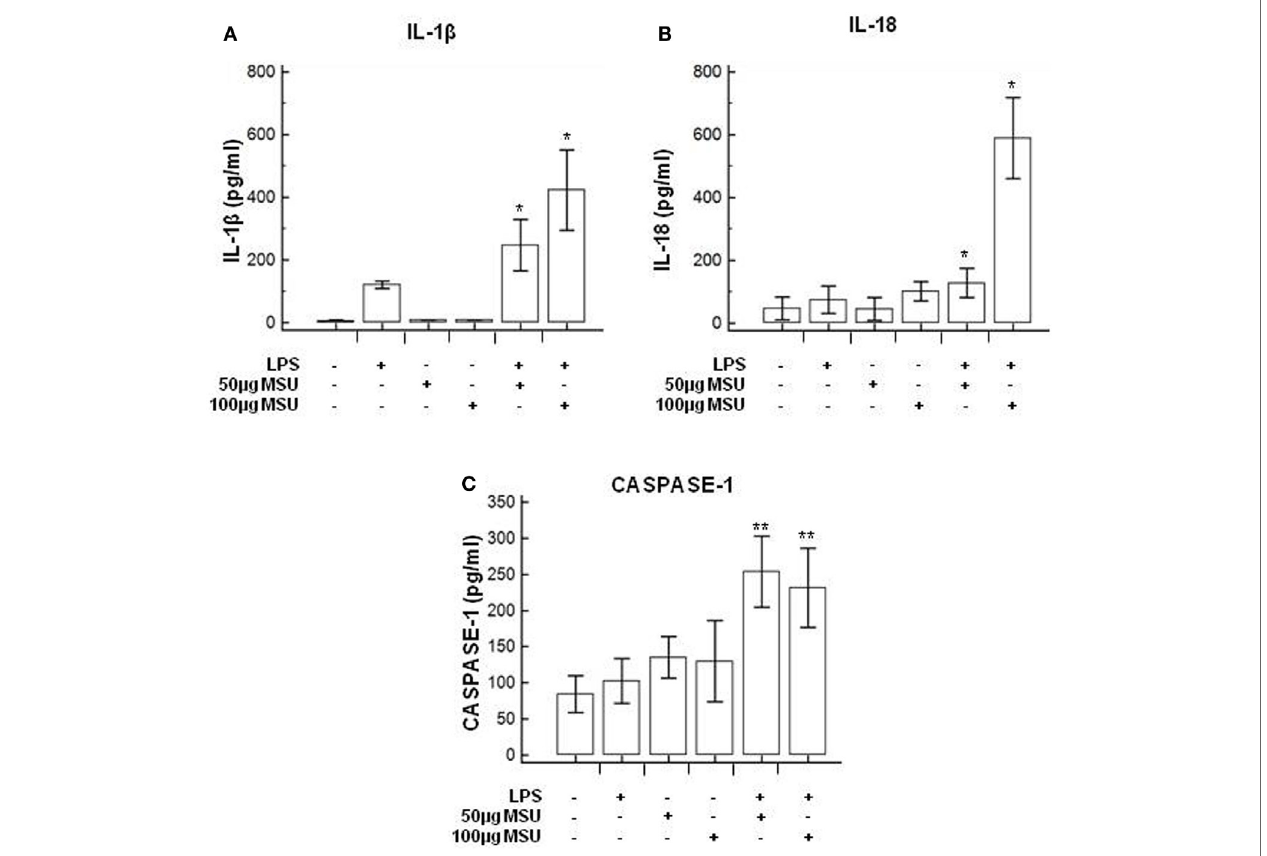
FigUre 3 | Modulation of inflammasome effector proteins by monosodium urate crystals (MSU) in THP1 cells. THP-1 cells were treated with lipopolysaccharide (LPS) (1 µg/ml) for 2 h and/or with the indicate concentration of MSU crystals for 22 h. The supernatants of cell cultures were collected and IL-1 β (a) , IL-18 (B) , and caspase-1 (c) release was measured by ELISA. Data are representative of three independent experiments and expressed as means ± SD. * p < 0.05, ** p < 0.01, *** p < 0.001 significant difference from cells